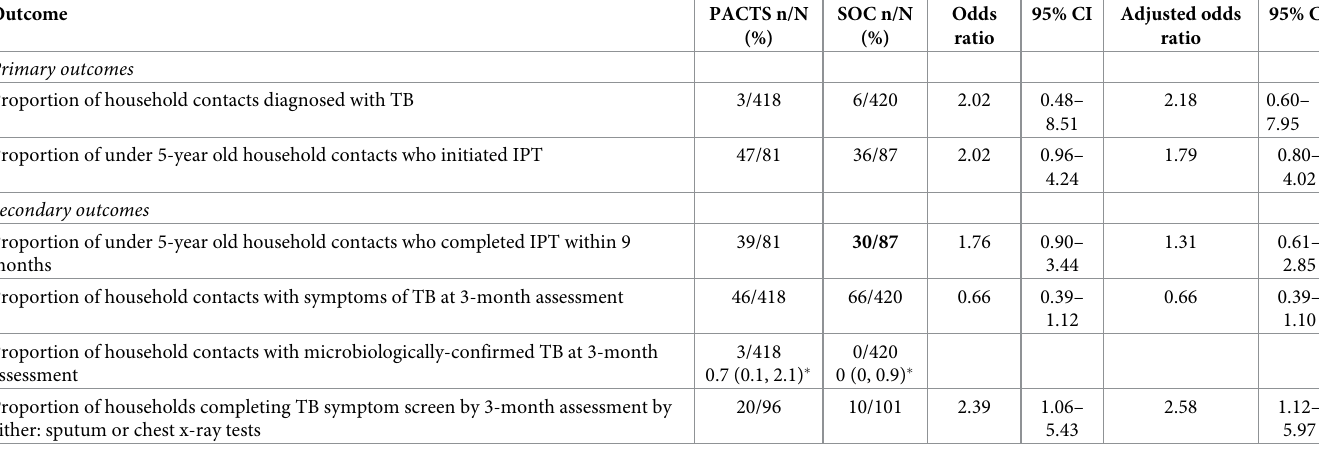
Table 2. Effect of interventions on primary and secondary outcomes, at